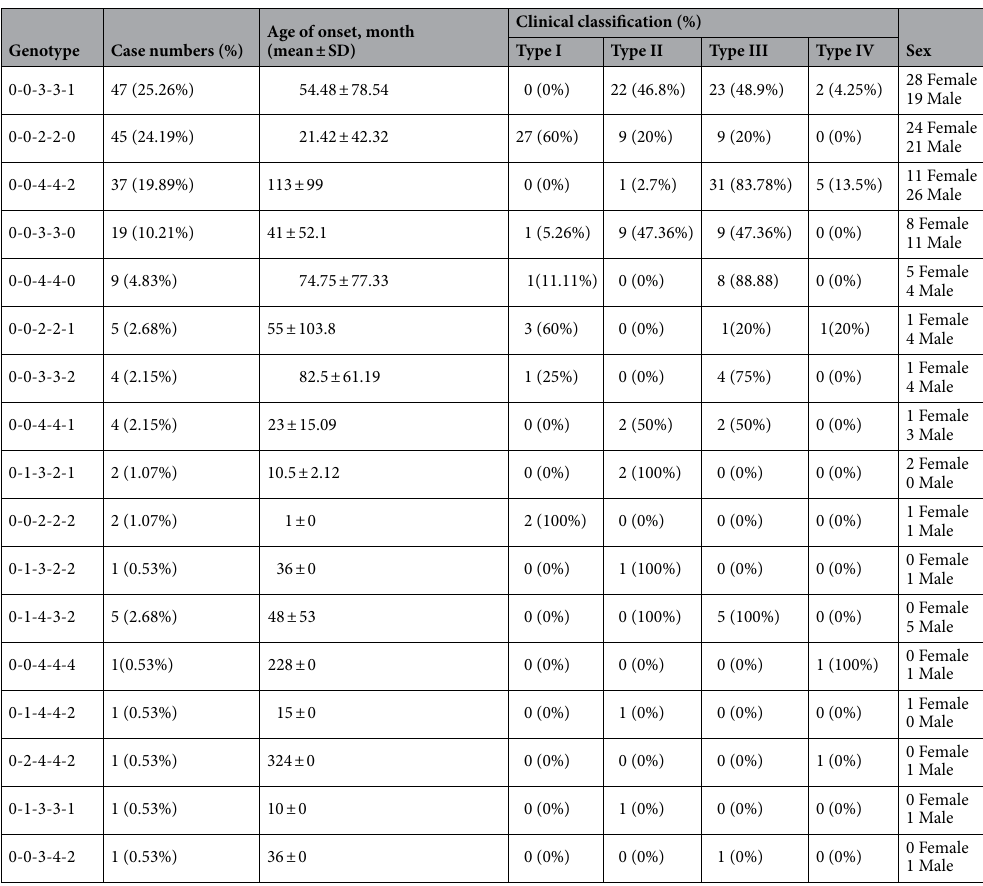
Table 4. Relationship between SMN1 (E7and E8) - SMN2 (E7and E8) - NAIP (E5) genotype and clinical phenotype of SMA.